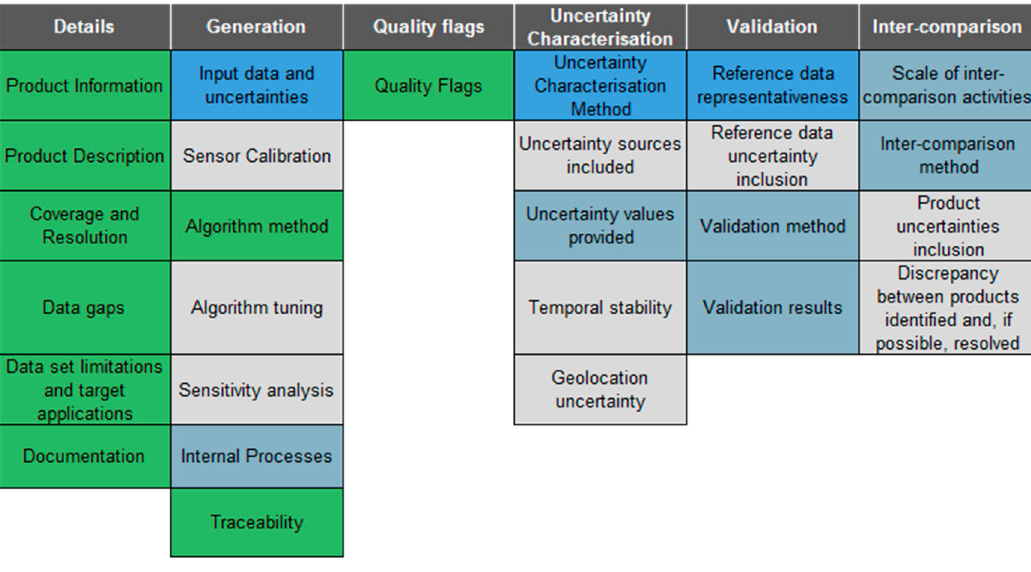
Figure 3. Quality Evaluation Matrices (QEMs) for the ( a ) CCI / C3S V3.1—chlorophyll-a concentration product and ( b ) Globcolour global merged—chlorophyll-a concentration product. The CCI product